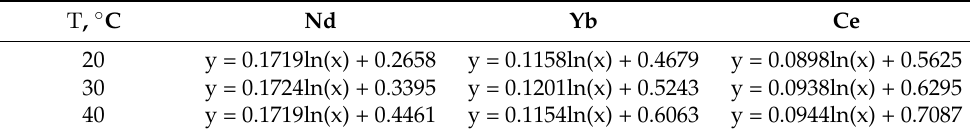
Figure 4. Dependence of lanthanide recovery on temperature and stirring time: ( a ) for Ce; ( b ) for Nd; ( c ) for Yb. An increase in temperature led to a regular increase in the degree of extraction. The dependencies were approximated by logarithmic dependence with a validity of 98%, the empirical approximation equations are shown in Table 5. Table 5. Degree of extraction versus time and temperature.